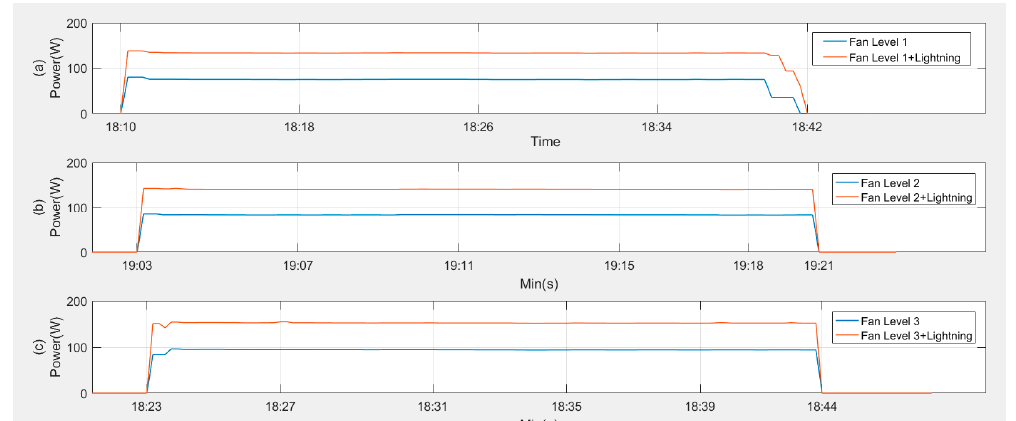
Figure 15. The power consumption curve of the range hood for fan speed ( a ) level 1, ( b ) level 2, and ( c ) level 3.